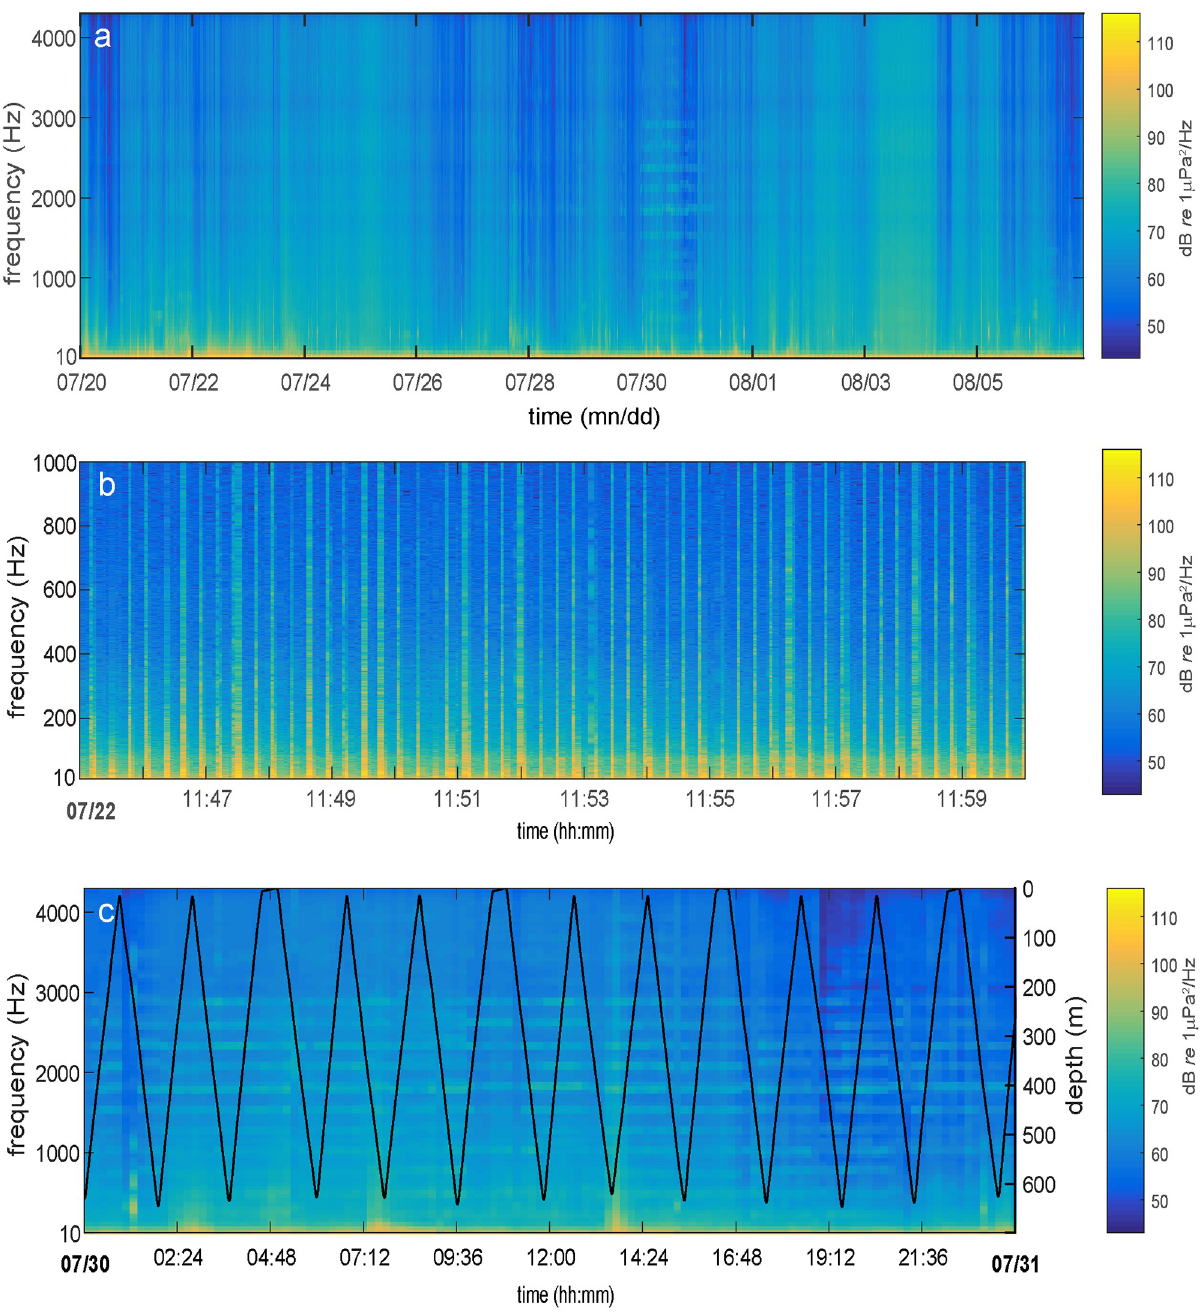
Fig 3. Glider spectrograms during the mission and glider dive profiles on July 30, 2012. a) A spectrogram calculated from 4 second hanning windows with no overlap showing the spectral energy content recorded during the 18 day glider mission duration. Broadband periods of elevated acoustic energy levels associated with higher wind speeds are observed over 1–3 day periods throughout the mission. b) A 15 minute period showing airgun explosion signals (10–1000 Hz) recorded by the glider near the beginning of the mission on July 22, 2012. c) A 1 day long spectrogram from July 30 showing the acoustic influence of a nearby vessel appearing as discrete bands in energy up to 3 kHz. The glider’s dive profiles throughout the day are also